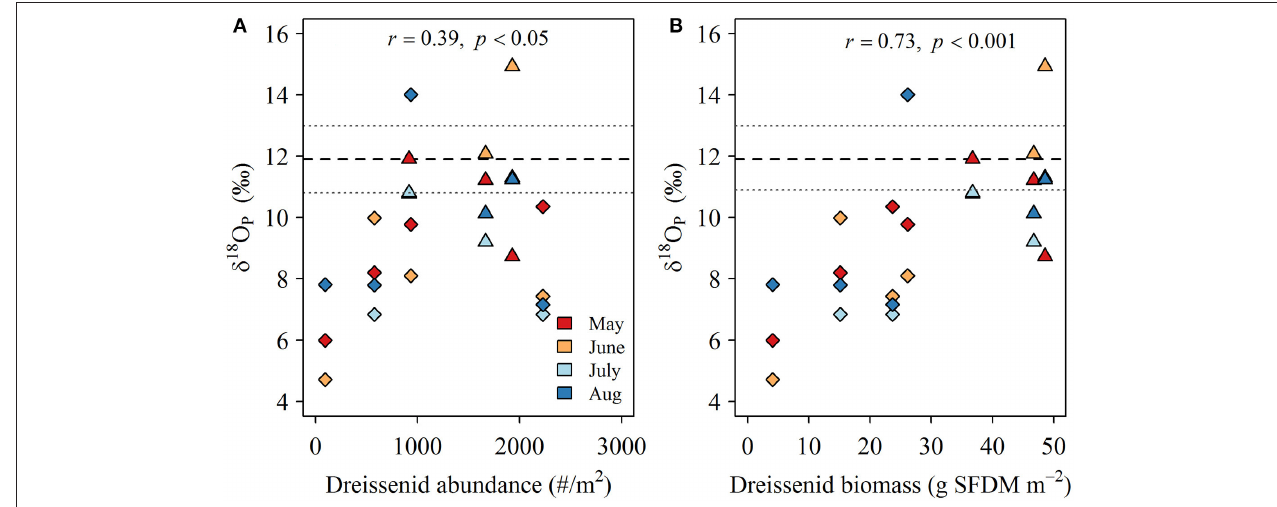
FIGURE 9 | (A) Relationship between the offset of δ 18 O p in LB samples from δ 18 O P_DM ( ‰ ; symbols) and dreissenid abundance (# m − 2 ) and (B) shell free dreissenid biomass (g SFDM m − 2 ). Long (short) dashed lines represents the mean (range) of experimentally determined δ 18 O p_DM